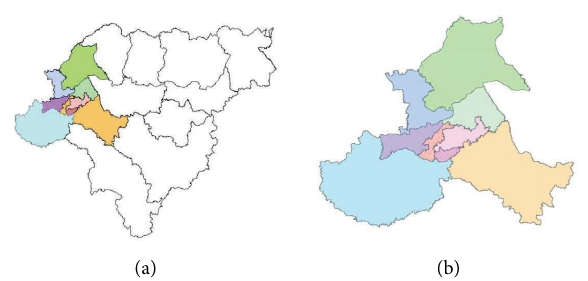
Figure 1: (a) Harbin city map. (b) Harbin municipal area